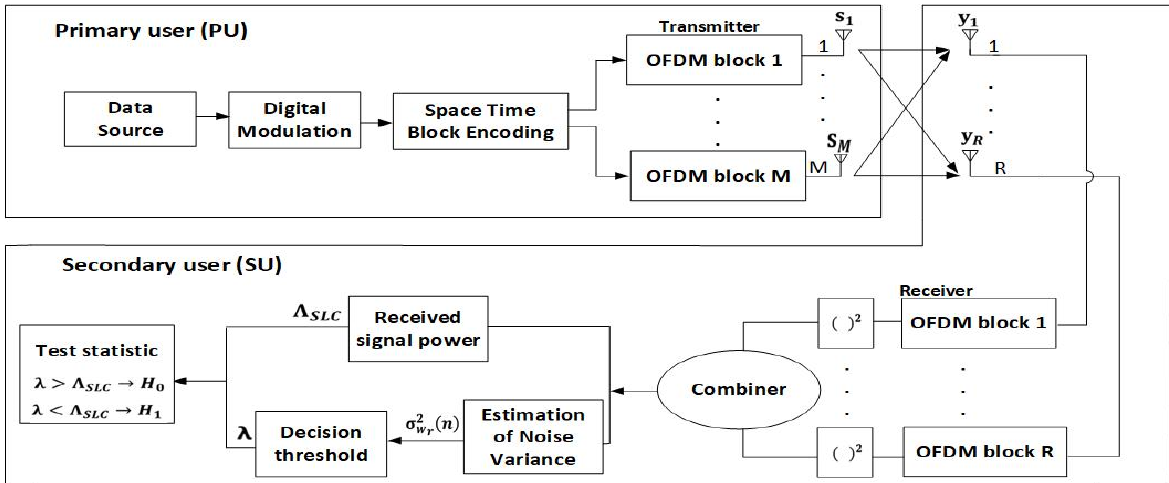
Figure 1. Block diagram of the ED process based on SLC in a MIMO-OFDM system with M Tx and R Rx branches. Table 1. Parameters used in the